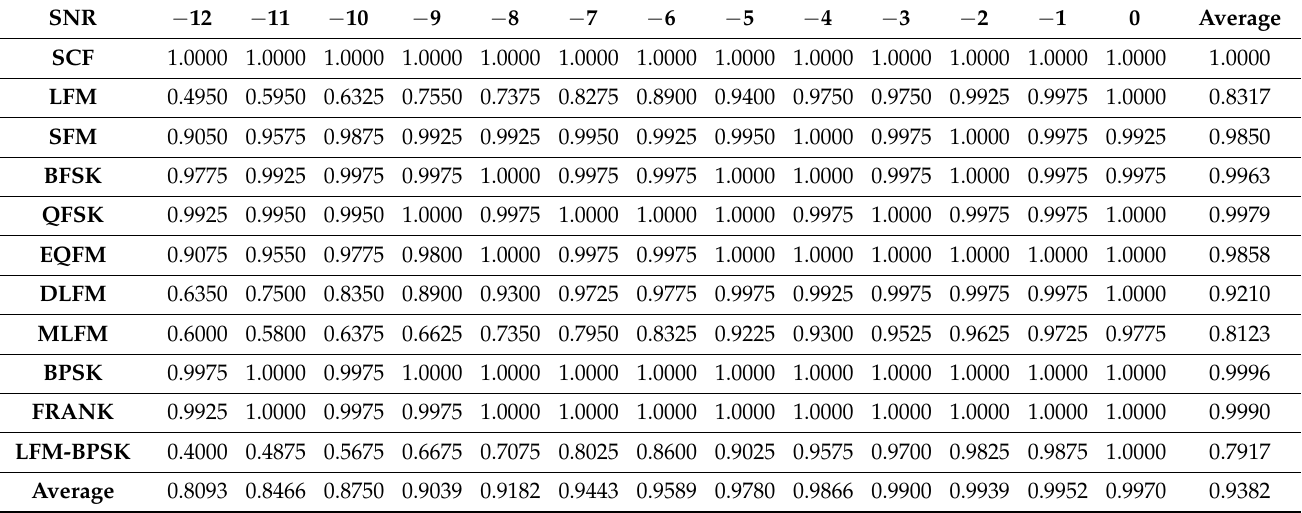
Table A28. The fully supervised classification results with the datasets in Situation Dataset 3.